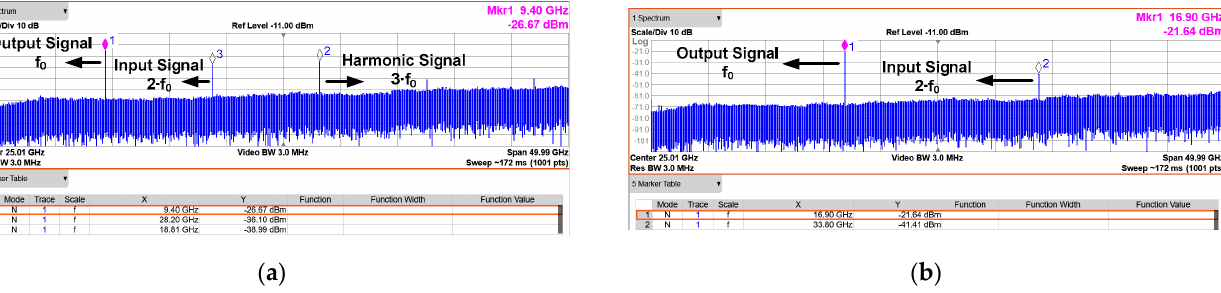
Figure 15. Full span spectrums ( a ) when the minimum input frequency is injected (18.8 GHz); ( b ) when the maximum input frequency is injected (33.8 GHz). The power difference between the output and input signals is approximately 10 dB or more.